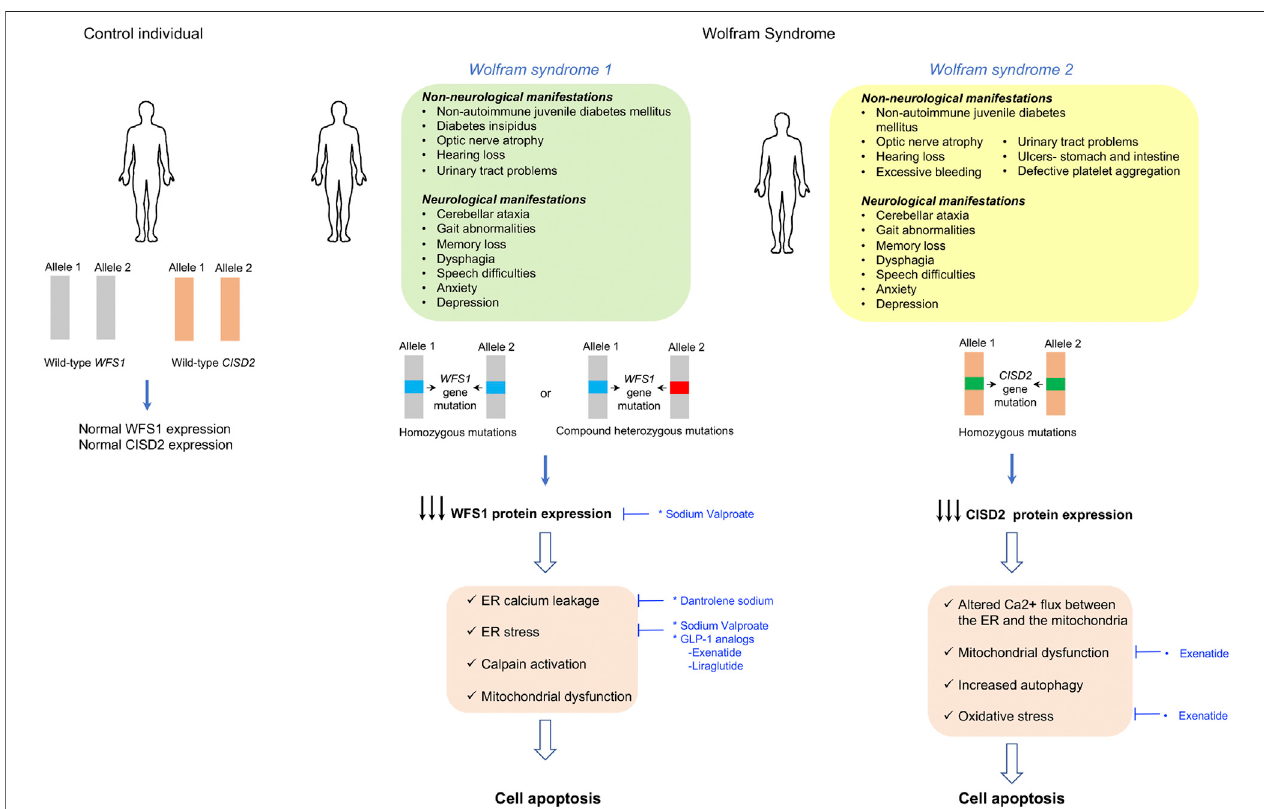
FIGURE 3 | Clinical manifestations and molecular disease mechanisms in Wolfram syndrome. Wolfram syndrome 1 is caused by homozygous or heterozygous mutations in the WFS1 gene, while wolfram syndrome 2 is caused by mutations in the CISD2 gene. This results in reduced WFS1 or CISD2 protein expression, which causesseveralcelldefectsleadingtocelldysfunctionandapoptosiswhichresultintheclinicalmanifestationsofthedisease.Repurposeddrugswithandwithoutorphan designationforWolframsyndromearehighlighted inblue alongwiththecellular dysfunctionsorclinicalmanifestations thattheytackle.ER- endoplasmicreticulum, GLP-1- glucagon-like